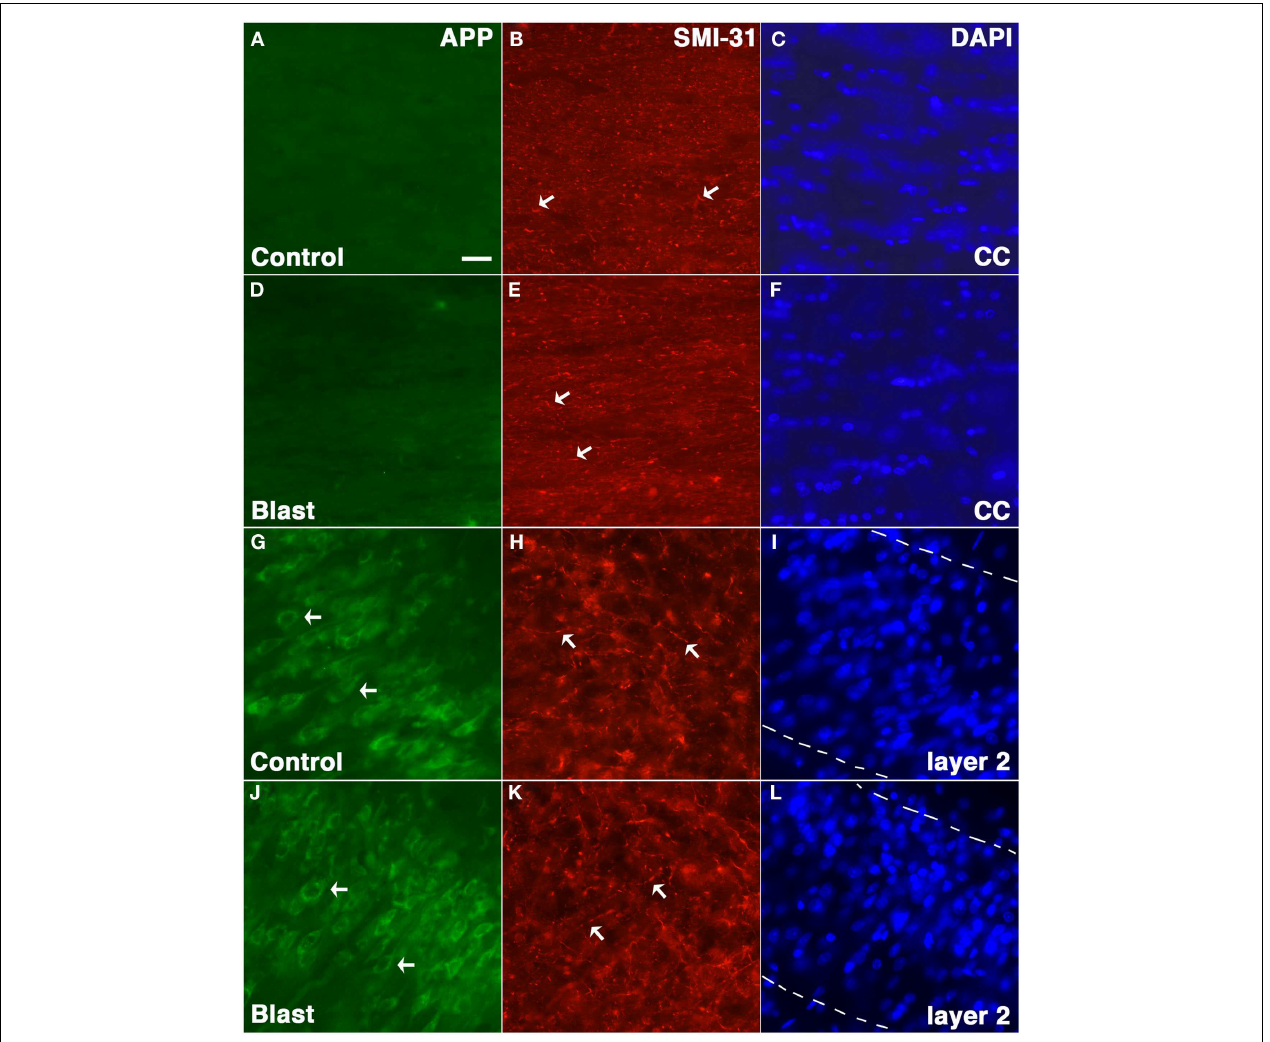
FIGURE 5 | Rats were exposed to 74.5kPa or control (i.e., sham) conditions and were sacrificed 24h later. Sections from control (A–C,G–I) and blast exposed (D–F,J–L) were immunostained with the rabbit anti-APP antibody 369 (A,D,G,J) directed against the APP C-terminus (green) and SMI-31 (B,E,H,K) a mouse monoclonal antibody which recognizes phosphorylated epitopes on the mouse mid-sized and heavy neurofilament proteins that are found mostly in axons (red). Sections counterstained with a DAPI nuclear stain (blue) are shown in